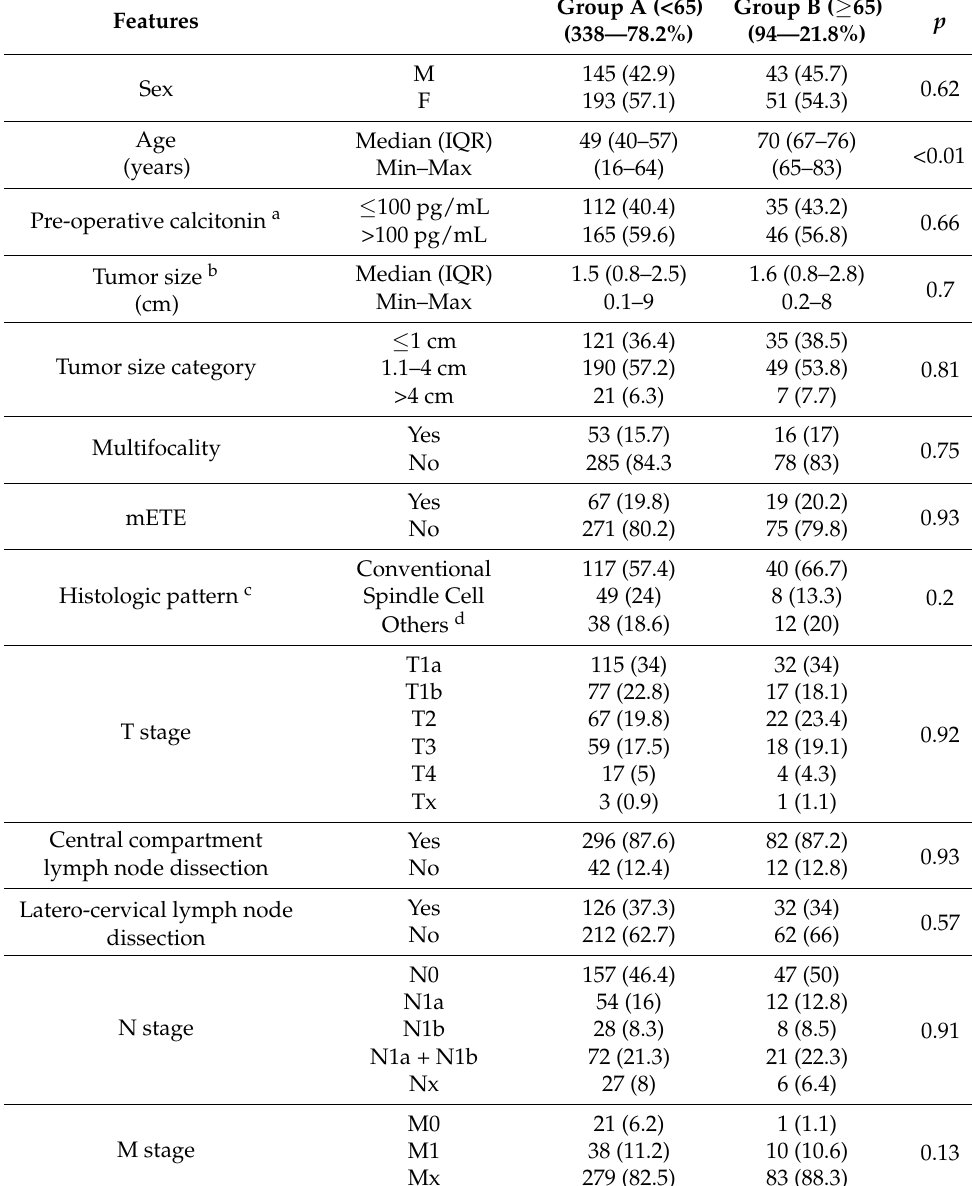
Table 2. Comparison of analyzed features in group A (<65 yrs) and B ( ≥ 65 yrs).